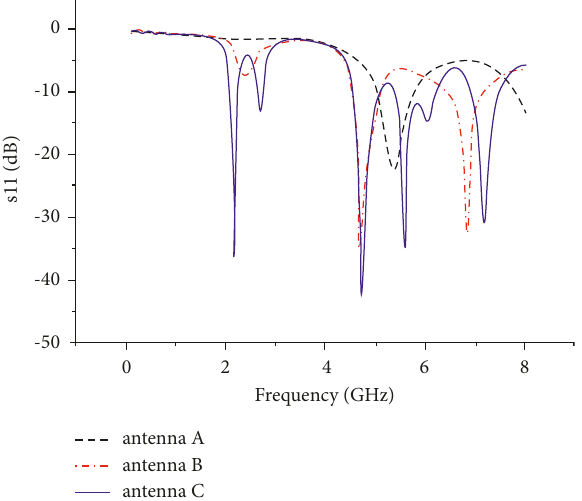
Figure 3: Comparison plot of antennas A, B, and C.